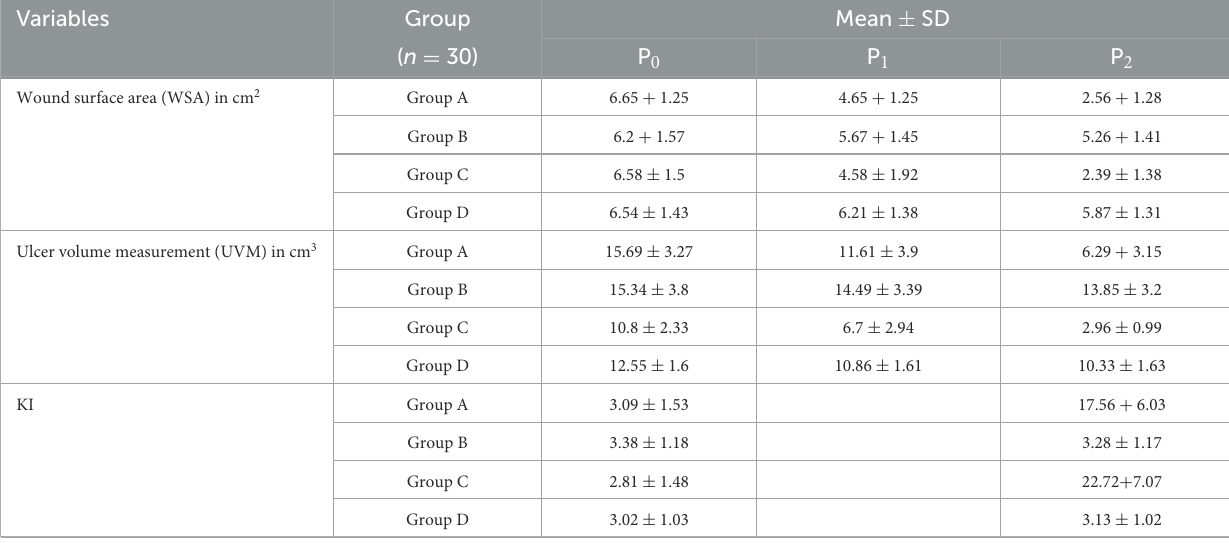
TABLE 2 Mean and standard deviation for outcome measures in the three measuring periods in each tested group.